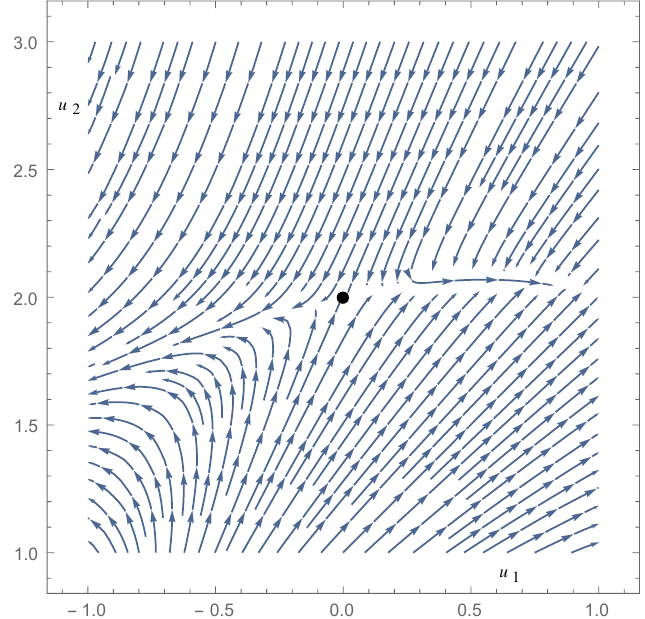
Figure 16. Phase space plot in the u 1 u 2 plane of isotropic vacuum solutions in exponential gravity, where u 1 is along the x -axis and u 2 is along the y -axis. The de-Sitter solution is given by the point ( 0,2 ) , which is represented by the dot at the center of the figure. The arrows show the direction of the solution flow. The phase flows clearly show that the de-Sitter solution is a saddle fixed